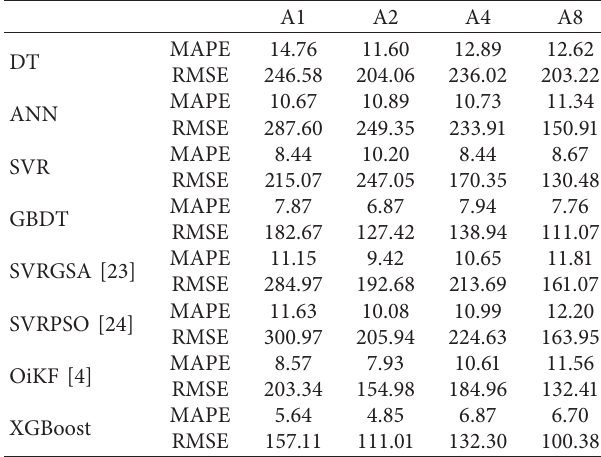
Figure 2: The MAPE of the model with regard to the forecasting lags. Table 1: Comparison of prediction performances of various